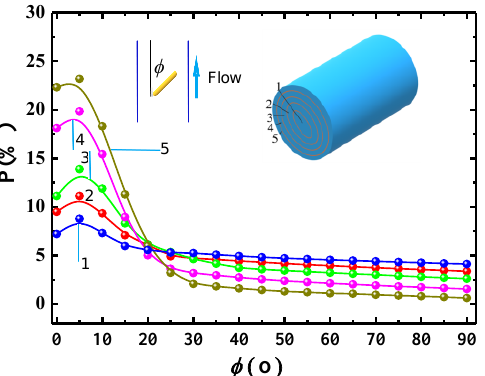
Figure 5. Distribution of mean particle orientation in different regions on the cross-section at outlet ( λ = 8, Re = 20,000, L/D = 200). ● : region 1; ●: 2; ●: 3; ●: 4; ●: 5.